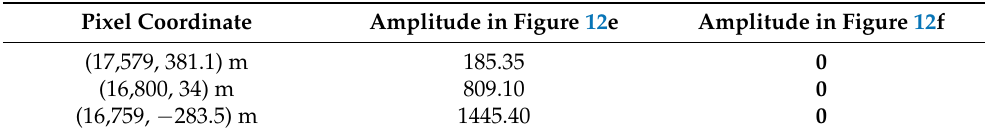
Table 3. Amplitude value of occluded pixel’s imaging result.